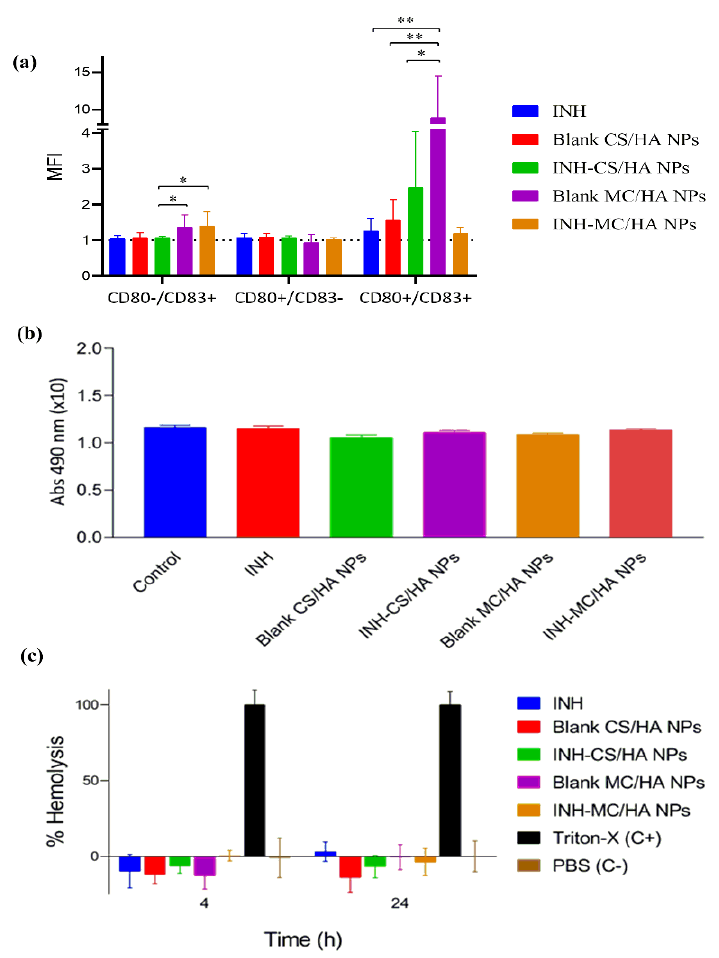
Figure 8. % Quantification of the expression of macrophage maturation markers, CD80 and CD83. All the results have been presented as mean fluorescence intensity (MFI) in macrophages incubated with NPs. The dotted line (MFI = 1) represents the signal from the macrophages incubated in culture (control). Data from blank MC/HA NPs were statistically significant (* p < 0.05, ** p < 0.001) ( a ), 2,3-Indoleamine dioxygenase (IDO) activity in macrophages cell culture ( b ), and in-vitro hemolysis assay after 4 and 24 h performed on fresh human blood obtained from donors after consent ( c ). All the results are expressed as mean ± SEM, n = 3 different blood donors ( p <